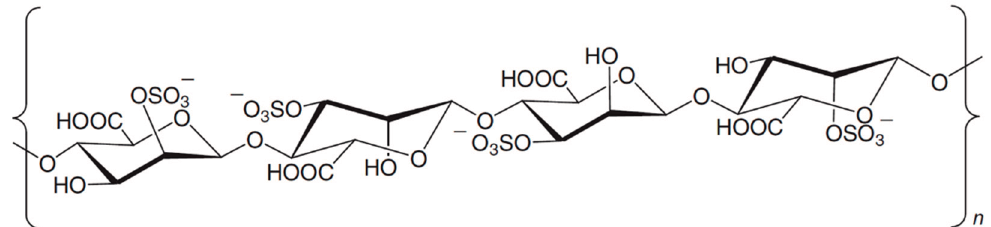
Figure 14. Sulfated polymannuroguluronate (SPMG, 73 ) isolated from brown algae Laminaria japonica